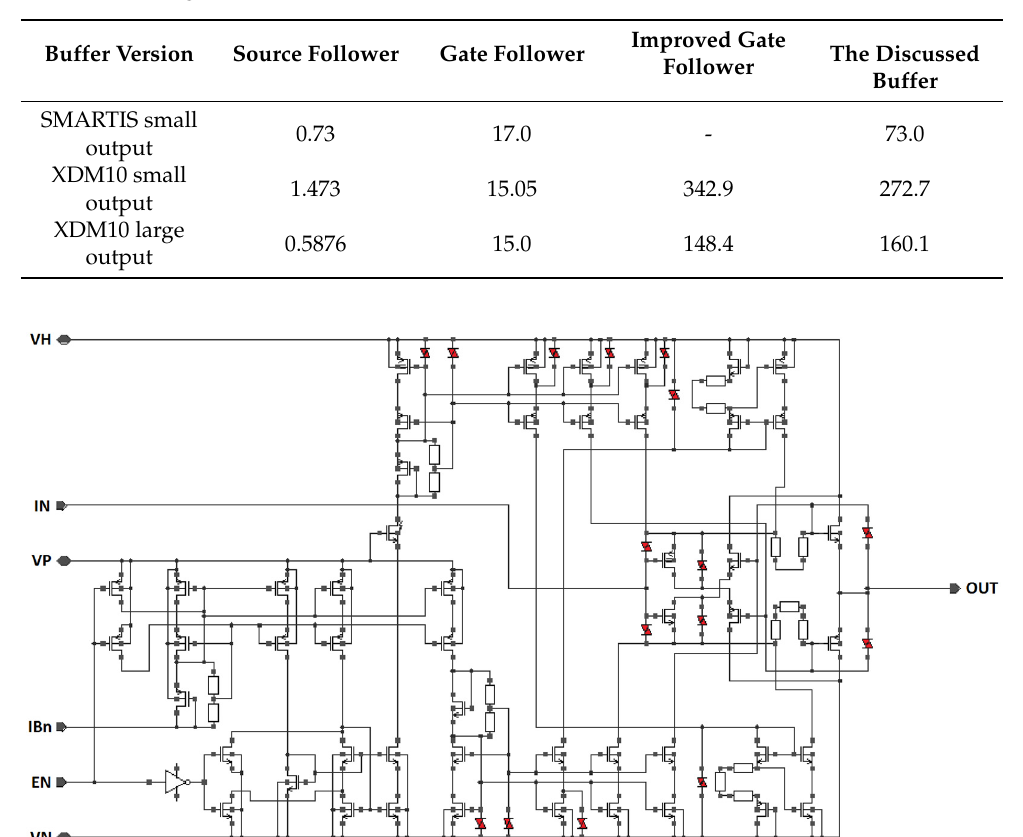
Figure 7. The buffer implemented with the ATMEL SMARTIS 0.8 μ m BDC-on-SOI process.